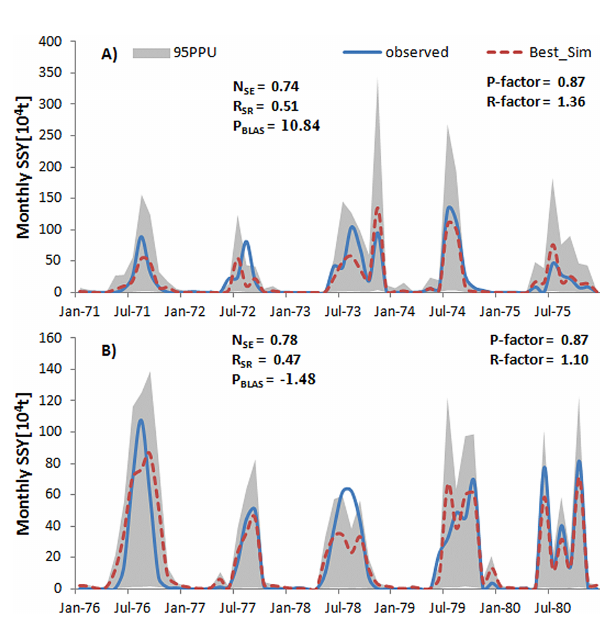
Figure 6. Comparison of the observed monthly suspended sediment yield (blue bold line) and simulated monthly suspended sediment yield (red dashed line) with 95% prediction uncertainty band at the Kejie hydrological station. Calibration and validation results are shown in Fig. 6a and